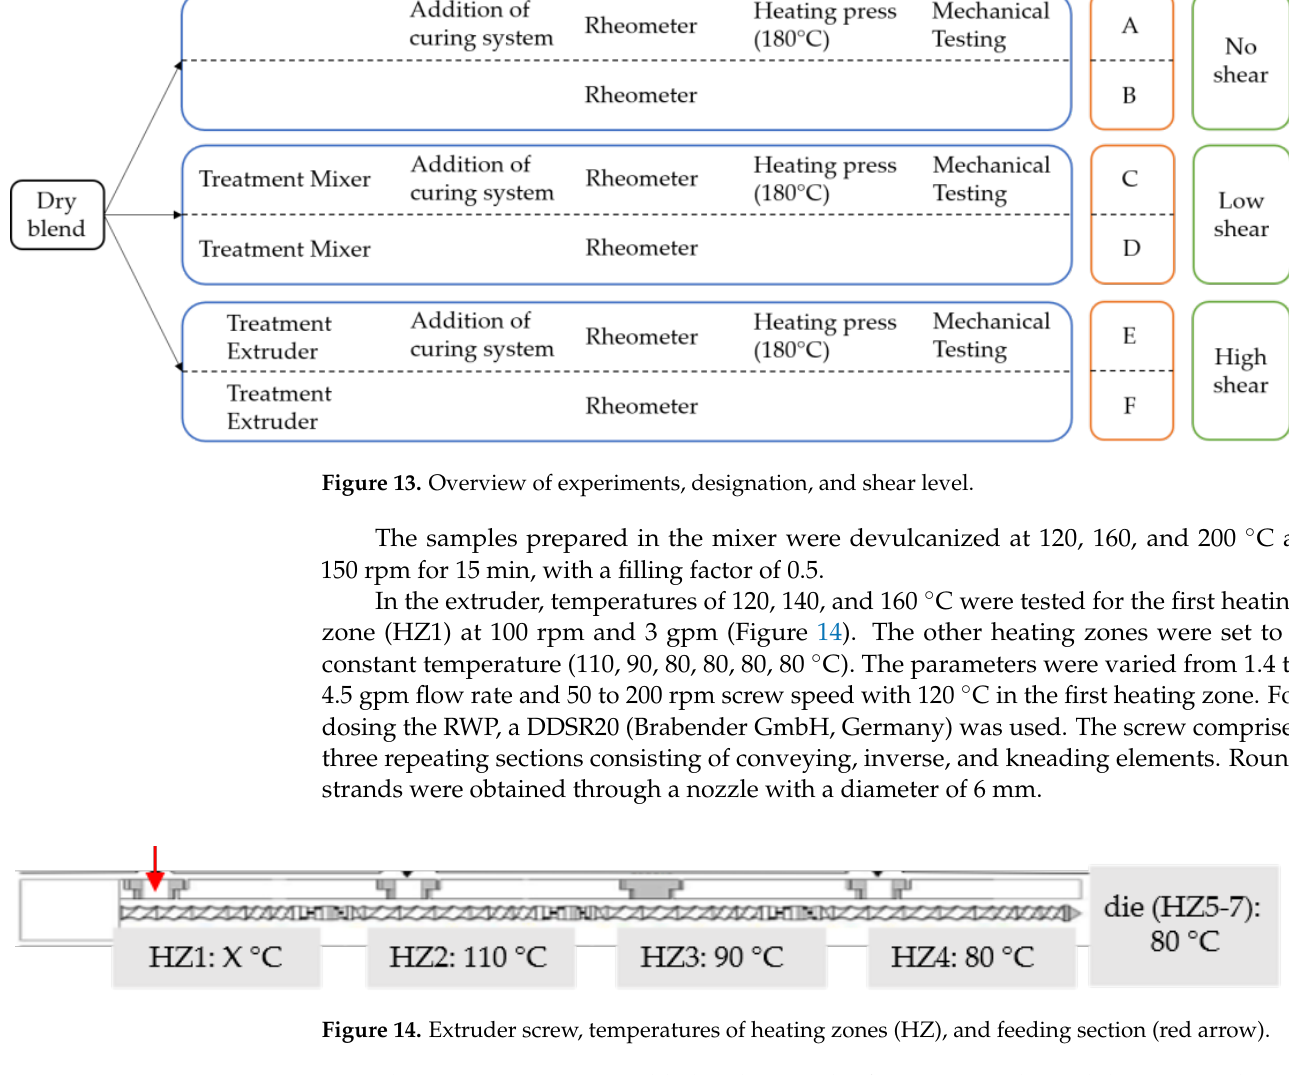
Figure 14. Extruder screw, temperatures of heating zones (HZ), and feeding section (red arrow).